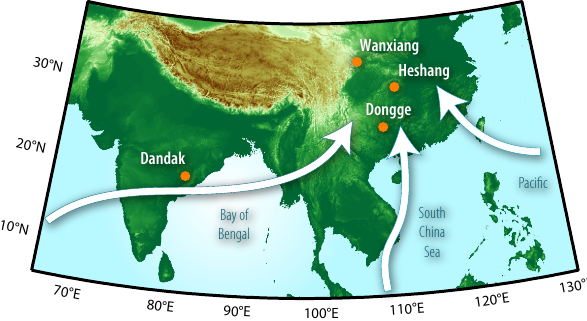
Fig. 11. Map showing the location of the paleo records and the main wind directions of the Indian and East-Asian summer monsoon sys- tems. Presently there are three major inflow corridors into Southern China, through the Bay of Bengal and over Indo-China, through the South China Sea and from the south east (Liu et al., 2008; Clemens et al.,